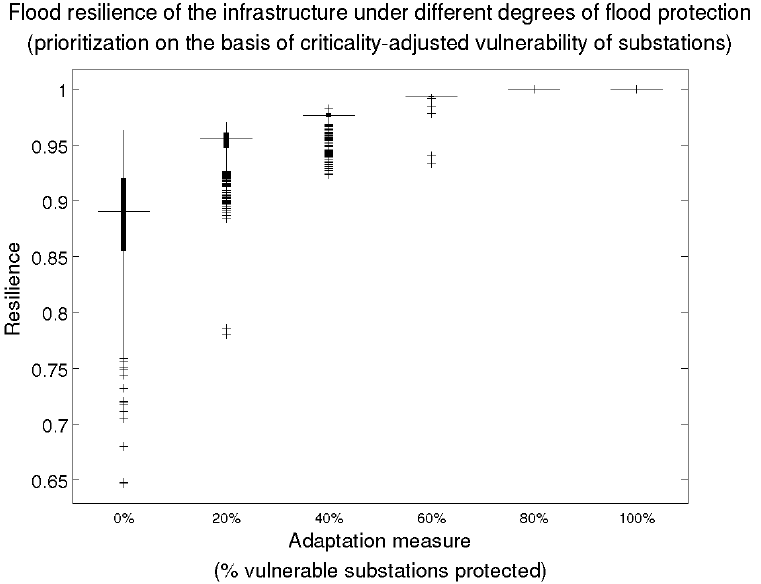
Figure 6. Comparison of resilience values obtained under the different flood protection strategies – with substations protected in order of their vulnerability (top pane) and in order of their criticality-adjusted vulnerability (bottom pane). The ends of the dark box indicate the 25th and 75th percentiles; the “whiskers” extending from the boxes include the most extreme data points not considered outliers; outliers are plotted individually as